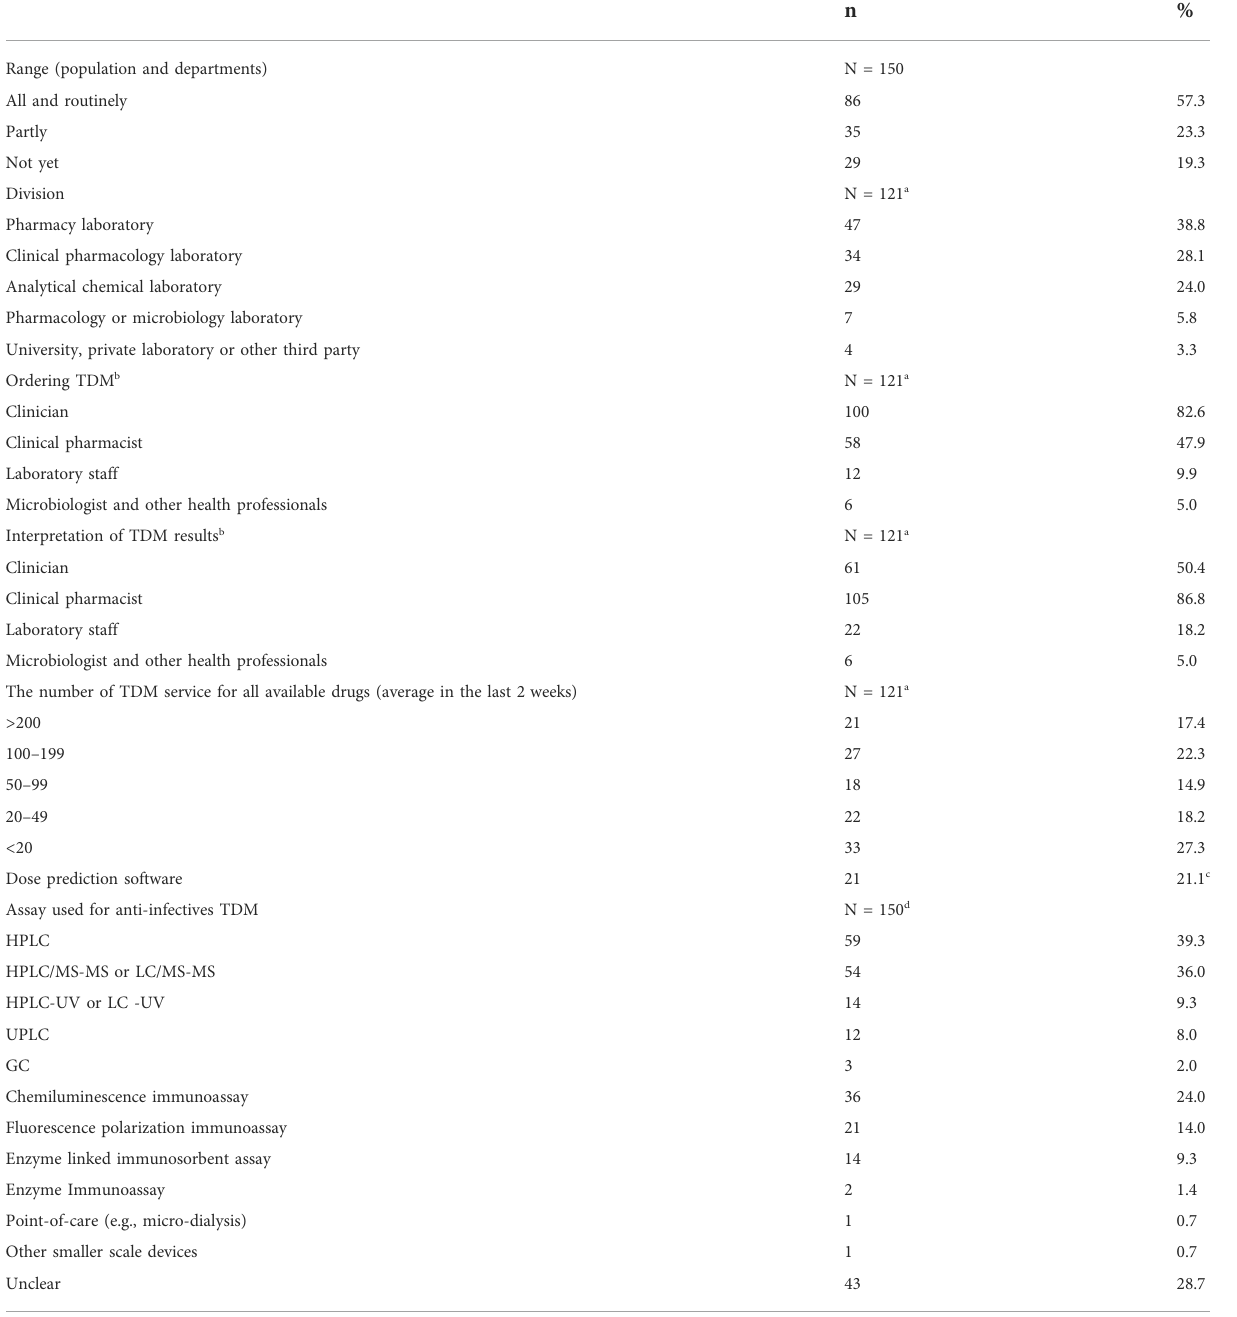
TABLE 3 Implementation of TDM